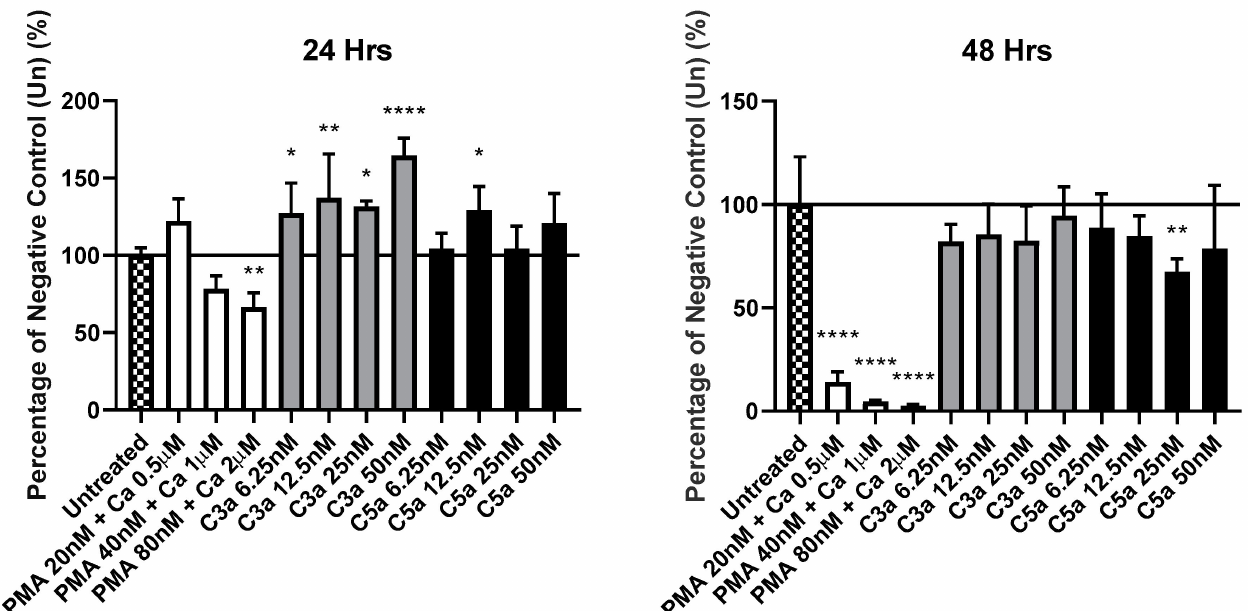
Figure 4. Investigation of cytotoxicity of materials via MTT assay. Level of mean absorbance measured at 570 nm, compared to that of the negative control (untreated), following 24 or 48 h incubation alongside various anaphylatoxins and stimulatory compounds. Values given are expressed as mean ( n = 8). * denotes p < 0.05, ** denotes p < 0.01, **** denotes p < 0.0001. Chequered bar represents negative control (untreated), white represents conditions containing concentrations of PMA and calcium ionophore. The grey and black represent conditions of C3a and C5a